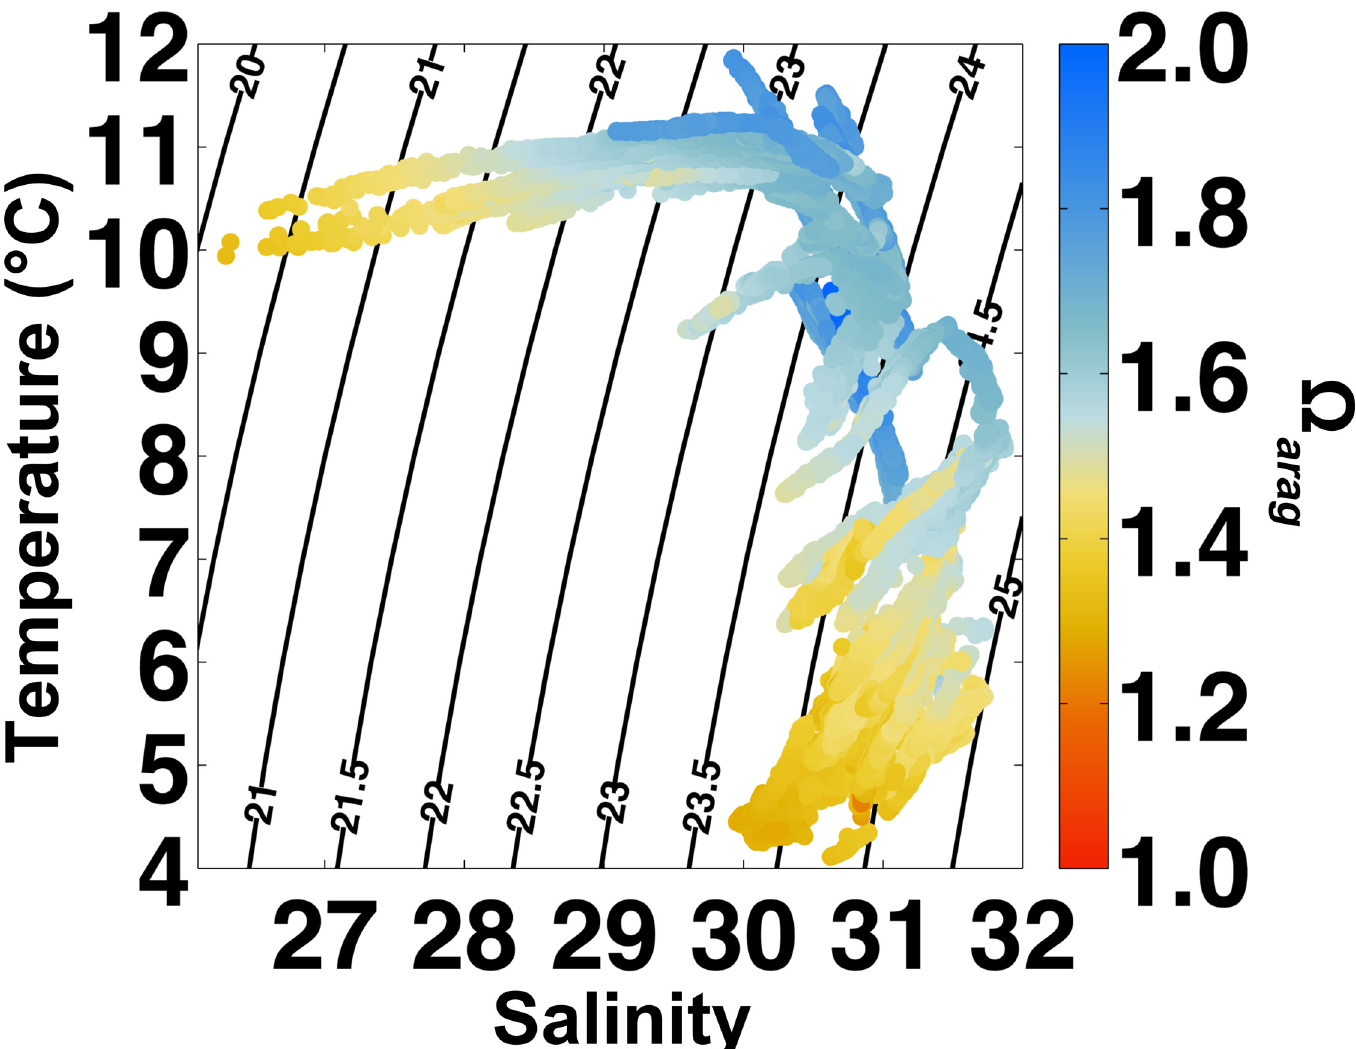
Fig 5. Temperature (°C) – salinity diagram with contours of seawater potential density anomaly ( σ t ) and Ω arag as colored dots. Note the two areas of sub-optimal Ω arag ( Ω arag < 1.5; warm colors) at the lowest salinities ( < 29) and coldest temperatures ( <